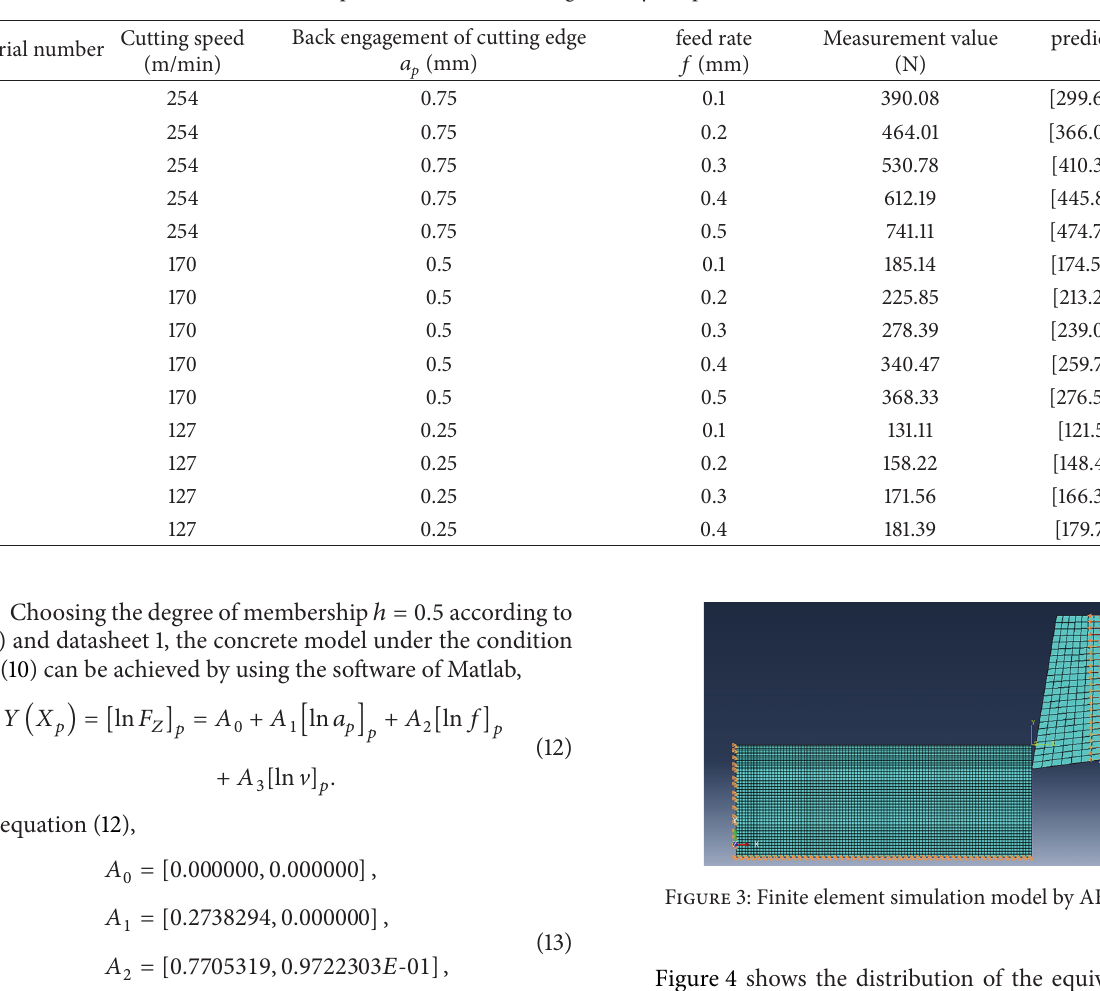
Table 4: The prediction of main cutting force by sculptured surface model ( ℎ = 0.5 ).